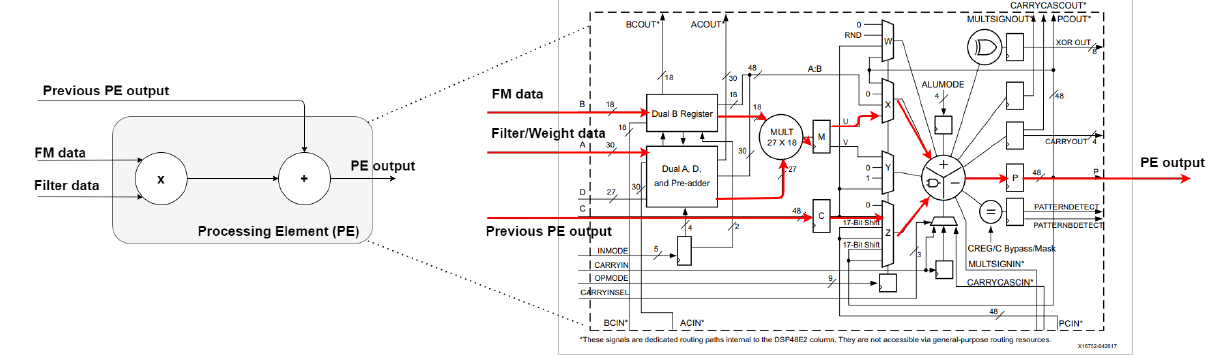
Figure 2. Processing element simplified block diagram on the left side. The right side illustrates a detailed version of DSP48E1 block diagram with input data path highlighted